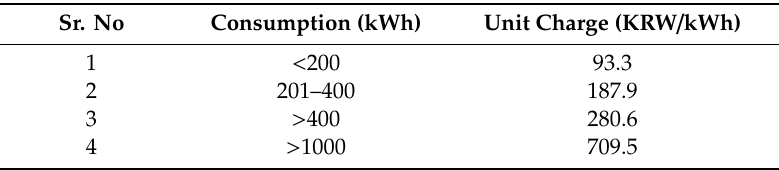
Table 1. Present residential electrical tariffs in Korea.